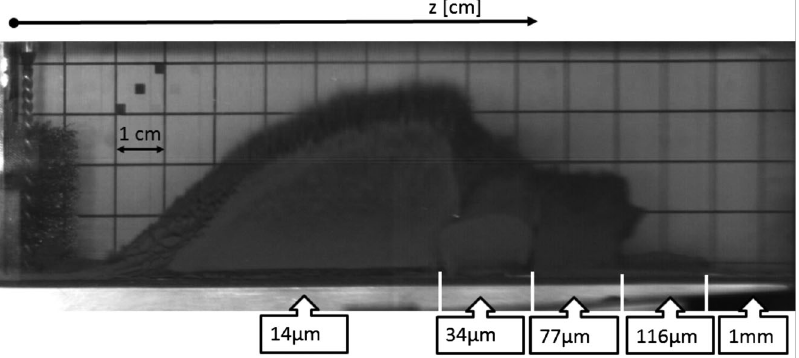
FIG. 22. High speed video image of powder eruption of different size spherical tungsten particles (helium at 20 mbar) 2 × 10 11 protons.